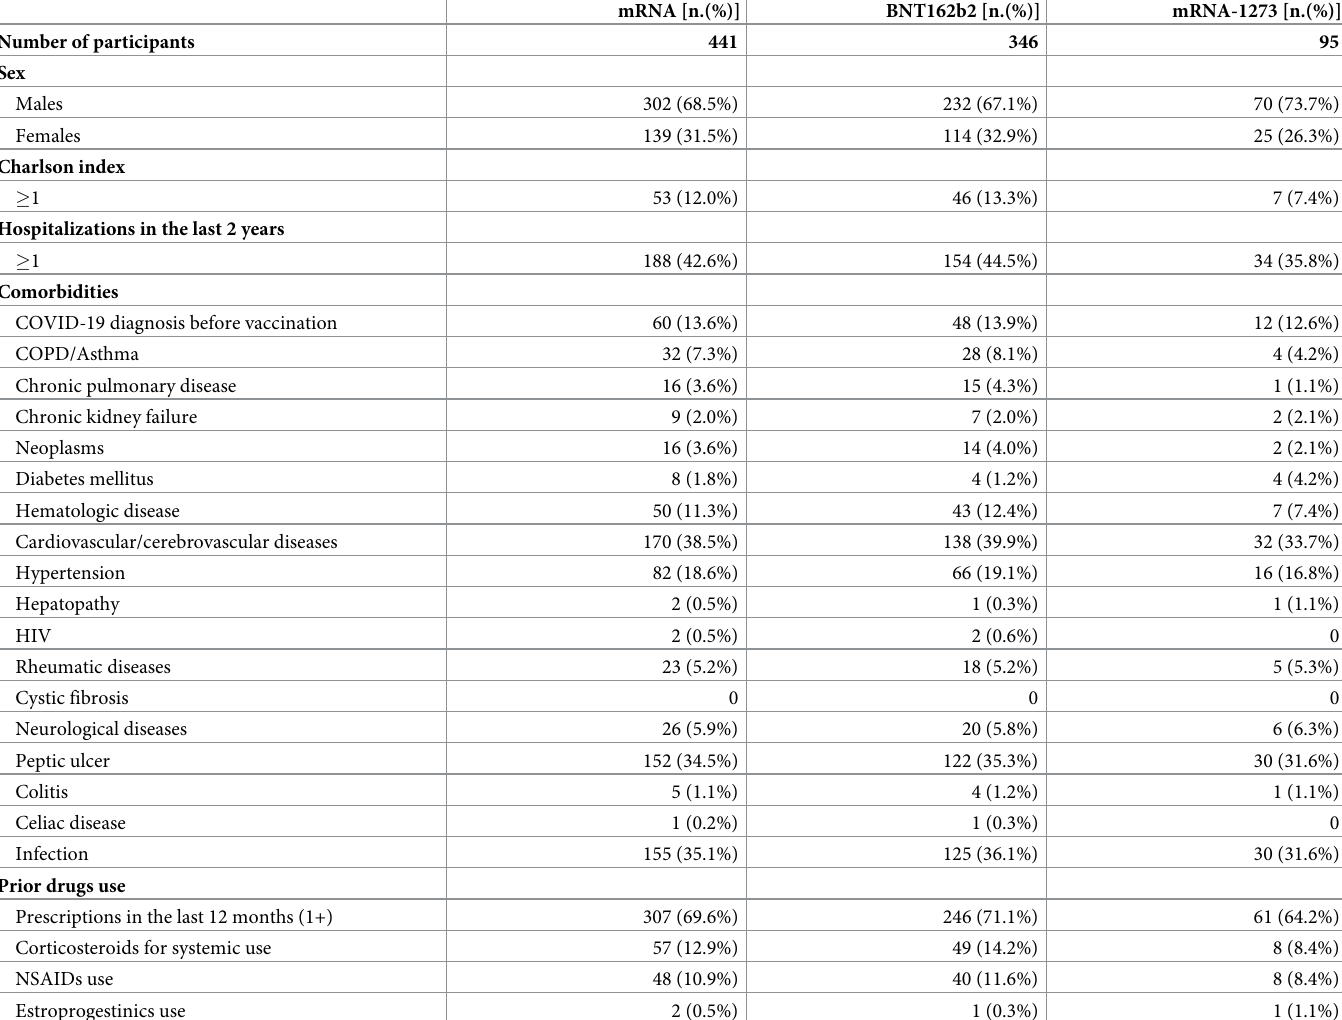
Table 1. Characteristics of cases of myocarditis/pericarditis (n. 441) among the mRNA-vaccinated population aged 12–39 years from 27 December 2020 to 30 Sep- tember 2021 by vaccine product.